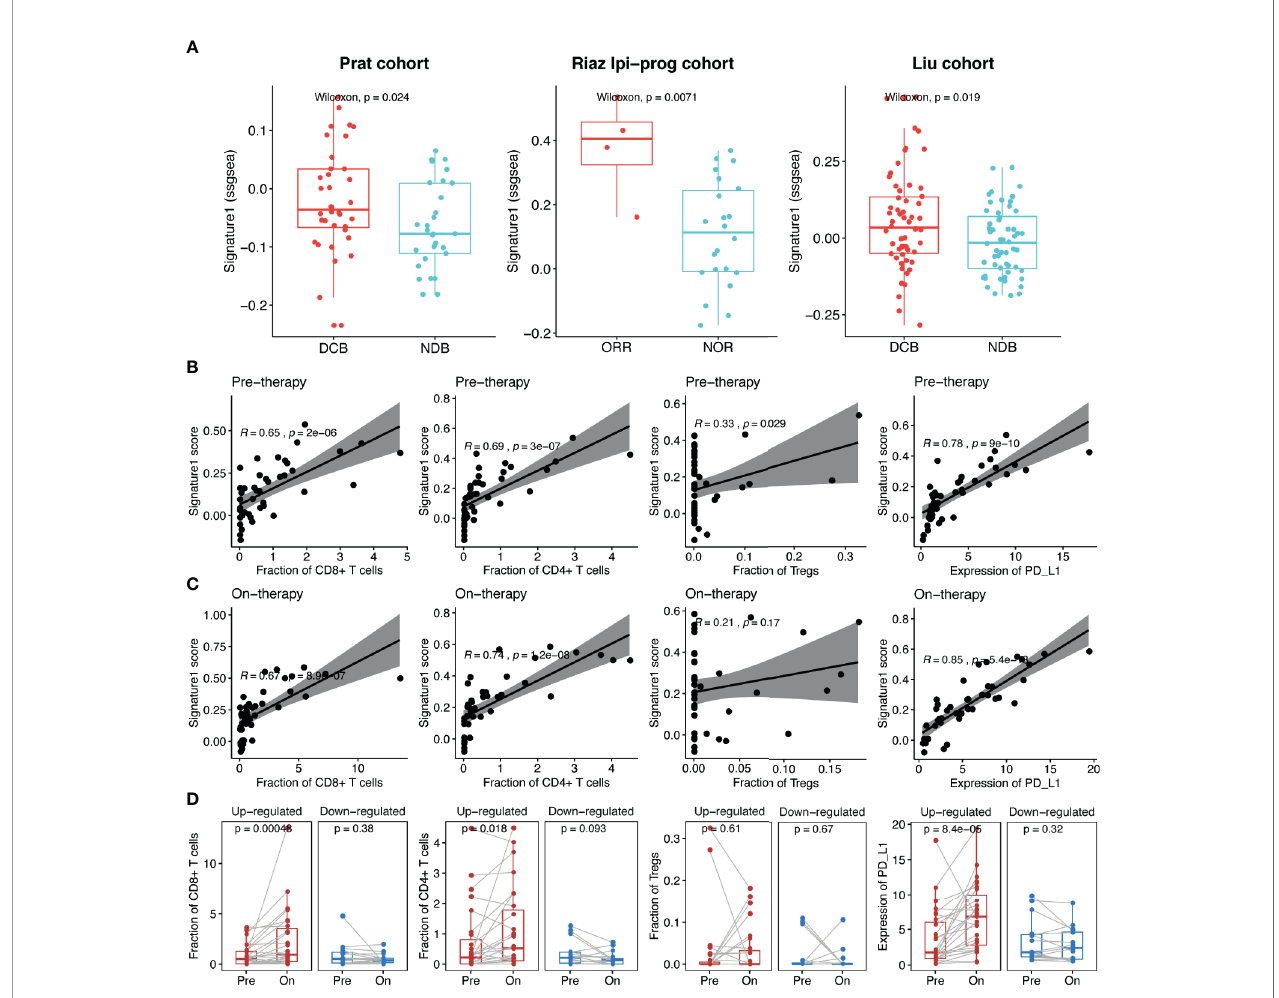
FIGURE 5 | The clinical ef fi cacy of Signature-1 validated in three published cohorts . (A) Correlations between Signature-1 score (used “ ssgsea ” method in GSVA R package) and durable clinical bene fi t in Prat et al., Riaz et al., and Liu et al. (B, C) Correlations between the fraction of CD8+ T cells, CD4+ T cells, Tregs, and PD-L1 expression level and Signature-1 in pre-therapy (baseline) and on-therapy samples. (D) Dynamic change of the fraction of CD8+ T cells, CD4+ T cells, Tregs, and PD-L1 expression level between pre-therapy (baseline) and on-therapy samples in Signature-1 upregulated and downregulated groups. Upregulated: Log2 fold change of Signature-1 score in on-therapy and pre-therapy samples > 0; Downregulated: Log2 fold change of Signature-1 score in on-therapy and pre-therapy samples <